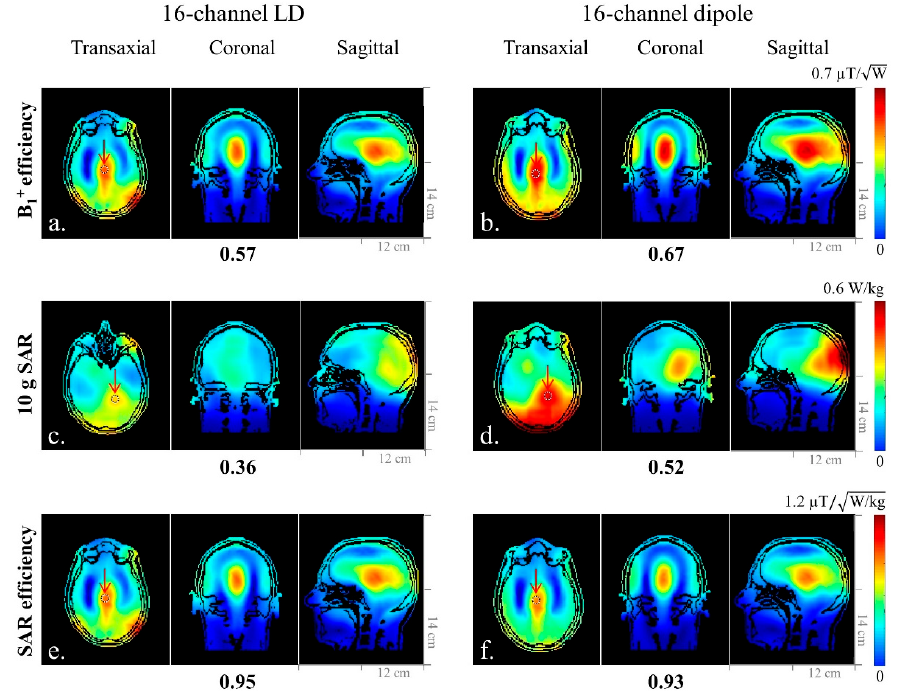
Figure 7. Simulated B 1+ efficiency ( a , b ), 10 g SAR ( c , d ), and SAR efficiency ( e , f ) maps of the 16-channel LD and dipole antenna arrays with a human head model in the transaxial, coronal, and sagittal planes. The number below each subfigure was the value from the ROI indicated in each transaxial plane. The 16-channel LD and dipole antenna arrays showed similar SAR efficiency values.